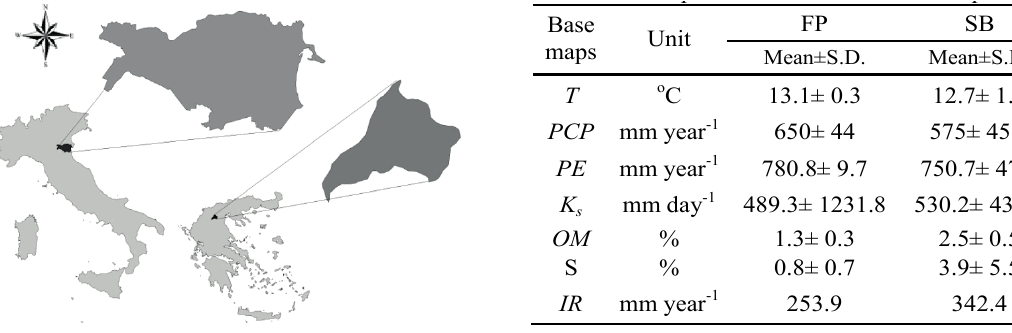
Fig. 1 Location of Ferrara province in Italy (FP) and of Sarigkiol basin (SB) in Greece, and the mean pixel values for each base